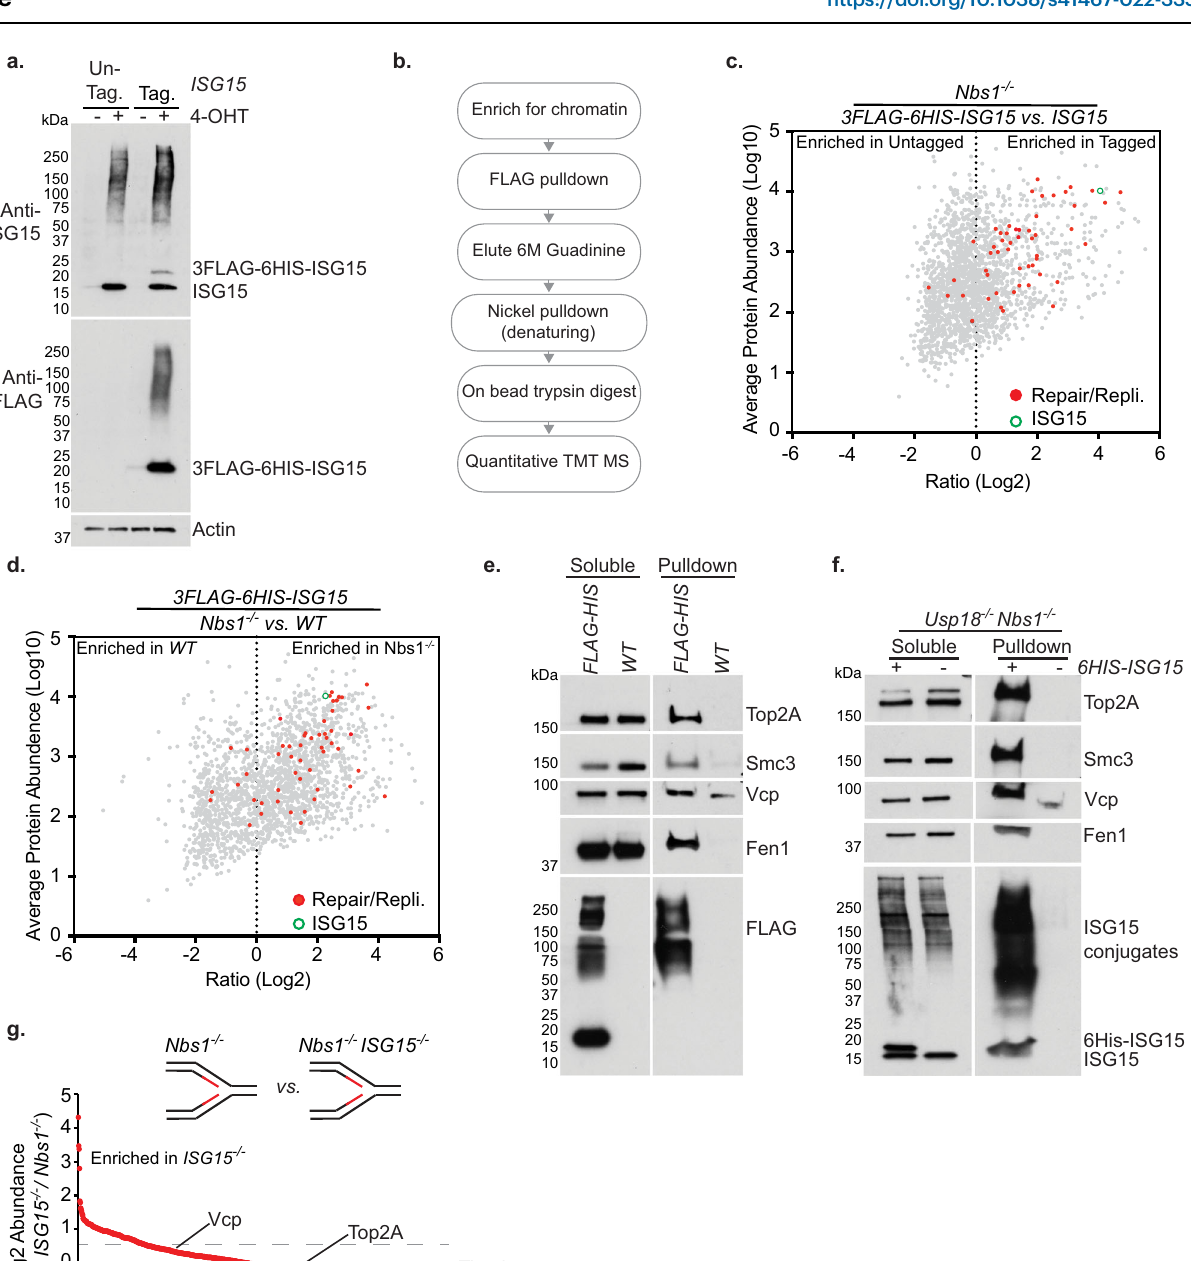
and pulldowns from chromatin were extracted from the same cells and run con- currently. f Western blot analysis of nickel pulldowns from the chromatin fraction of Usp18 − / − Nbs1 − / − and Usp18 − / − Nbs1 − / − with or without expression of an inducible exogenous 6HIS-ISG15. Soluble and pulldown samples were extracted from the same cells and run concurrently. g IPOND-SILAC-MS from Nbs1 − / − vs.Nbs1 − / − ISG15 − / − cells. Proteins identi fi ed in at least two out of three independent experiments rankedbymeanLog2ratio.Boundariesforenriched/depletedproteinsrepresented by dotted lines at Log2 abundances of ≥ 0.6 and ≤− 0.6. Source data are provided with this